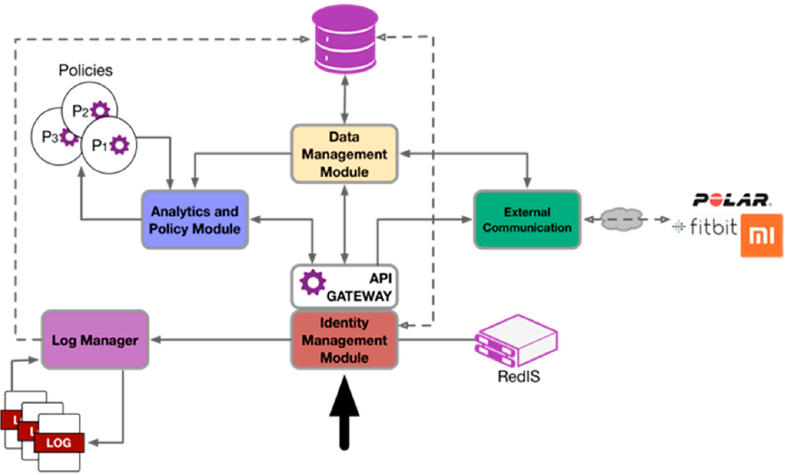
Figure 5. Distribution of the modules that comprise the analytical server and the interactive processes between them.